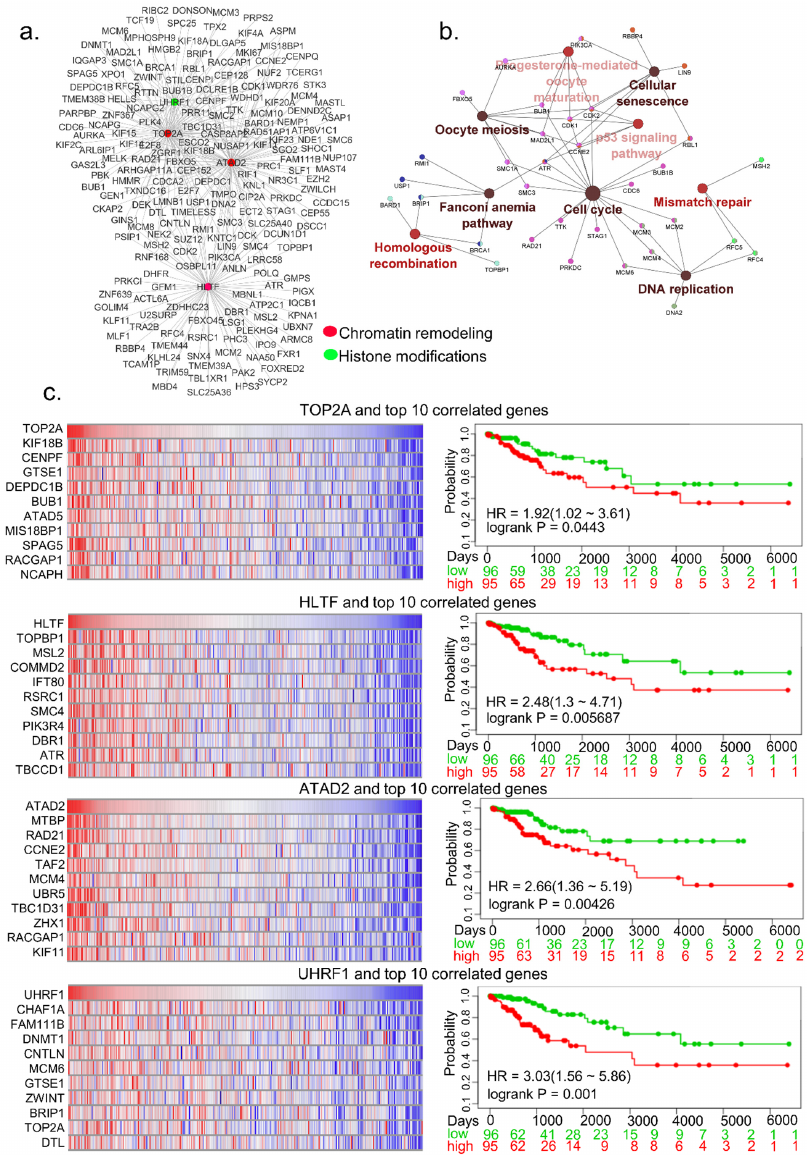
Figure 4. Significance of highly upregulated epigenomic and chromatin regulators in cervical cancer. ( a ) Network of four epigenomic and/or chromatin modifiers, upregulated over 2-fold, and its correlated genes. Epigenomic regulators are represented with colored dots. ( b ) KEGG pathway enrichment analysis of epigenomic regulator and its correlated genes. Larger nodes, the enriched pathway, and smaller nodes represent the genes involved in the pathway. ( c ) Heatmap representation of mRNA expression of epigenomic regulator and top 10 correlated genes (right panel), and Kaplan–Meier curves of four top upregulated epigenomic regulators and their correlated genes in CESC-TCGA cervical squamous cell carcinoma. Red and green color represents high and low risk, respectively. The X-axis represents survival days. Numbers below the axis represent the number of patients not facing an event along time for each